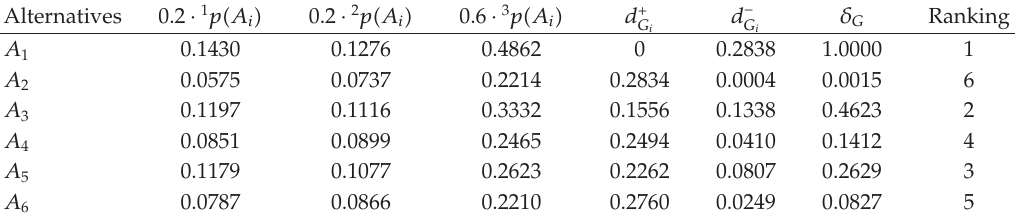
Table 11: The weighted relative closeness matrix by using importance weight λ (cid:8) (cid:2) 0 . 2 , 0 . 2 , 0 . 6 (cid:3) and ranking. Alternatives